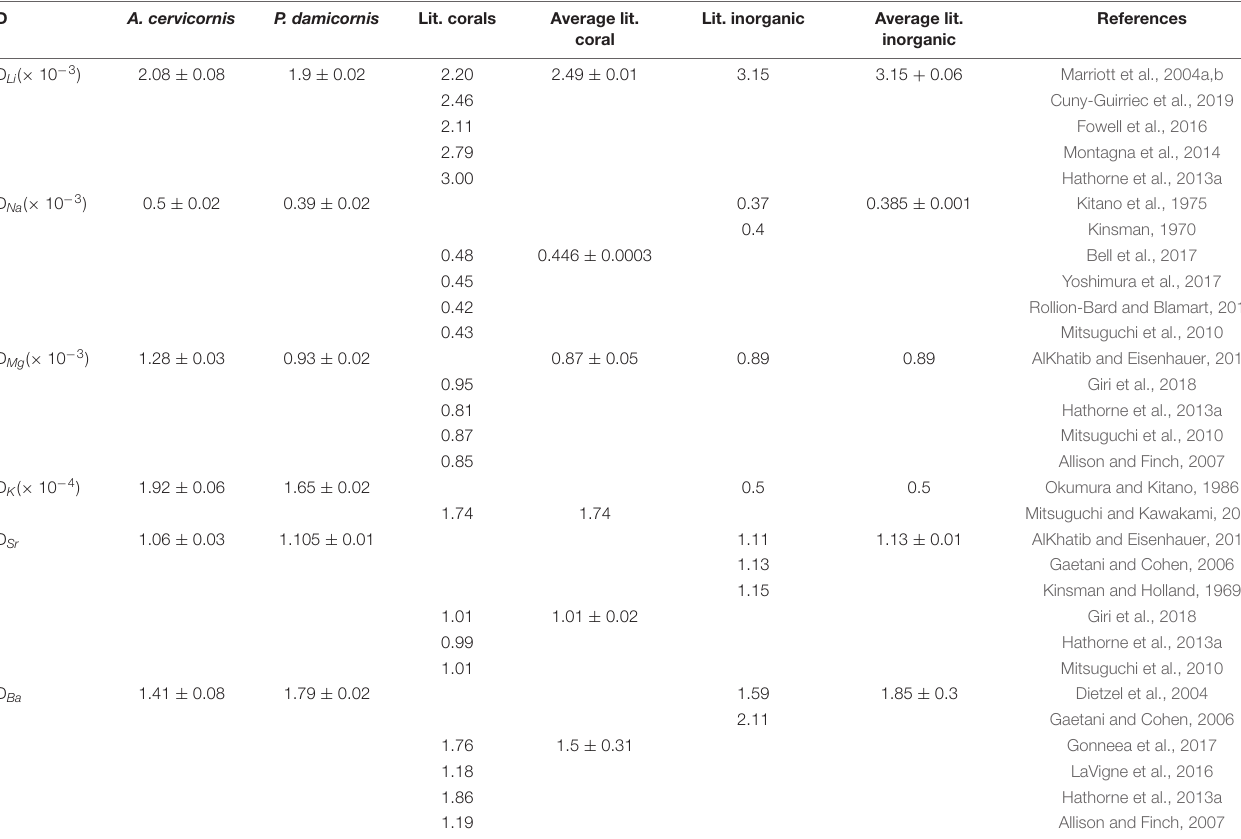
TABLE 3 | D El values for experimental corals compared to various coral species (field collected and experimental normalized to 25 ± 3 ◦ C) and inorganic